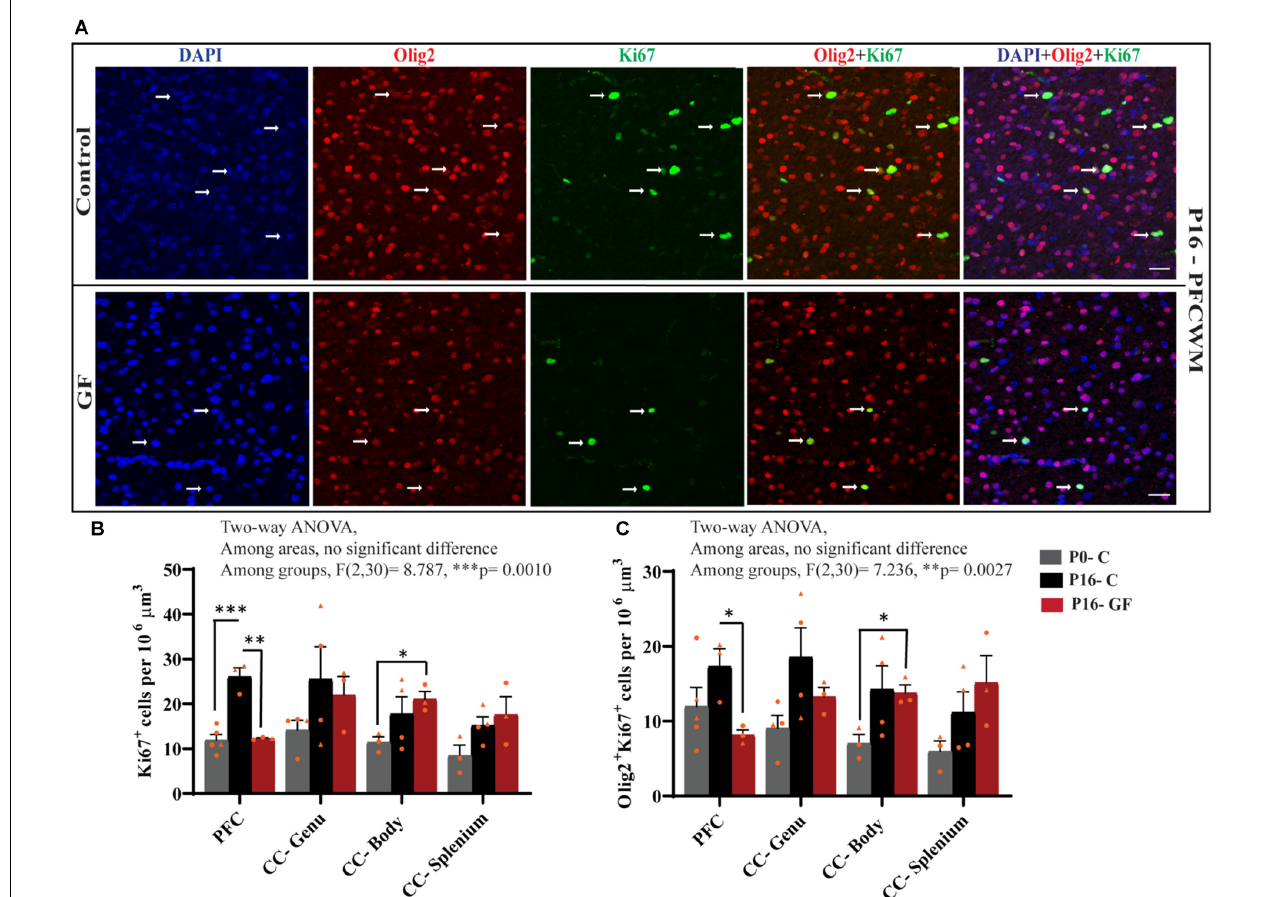
FIGURE 6 | Region-specific reduction oligodendrocyte proliferation in germ-free piglets at P16. (A) Representative confocal images showing all cells (DAPI+, blue), OLs (Olig2+, red), proliferating cells (Ki67+, green), and proliferating OLs (Olig2+Ki67+, yellow) and merged images in P16 control and germ-free (GF) animals. Scale bars, 50 µ m. Quantification of the number of Ki67+ cells (B) and Olig2+Ki67+ proliferating OLs (C) . Individual male animals are marked by yellow triangles and female animals are marked by yellow circles. Data expressed as mean ± SEM, n = 3–5 animals/group. ∗∗ p < 0.0001, two-way ANOVA; ∗ p < 0.05, ∗∗ p < 0.01, ∗∗∗ p < 0.001, unpaired student’s t